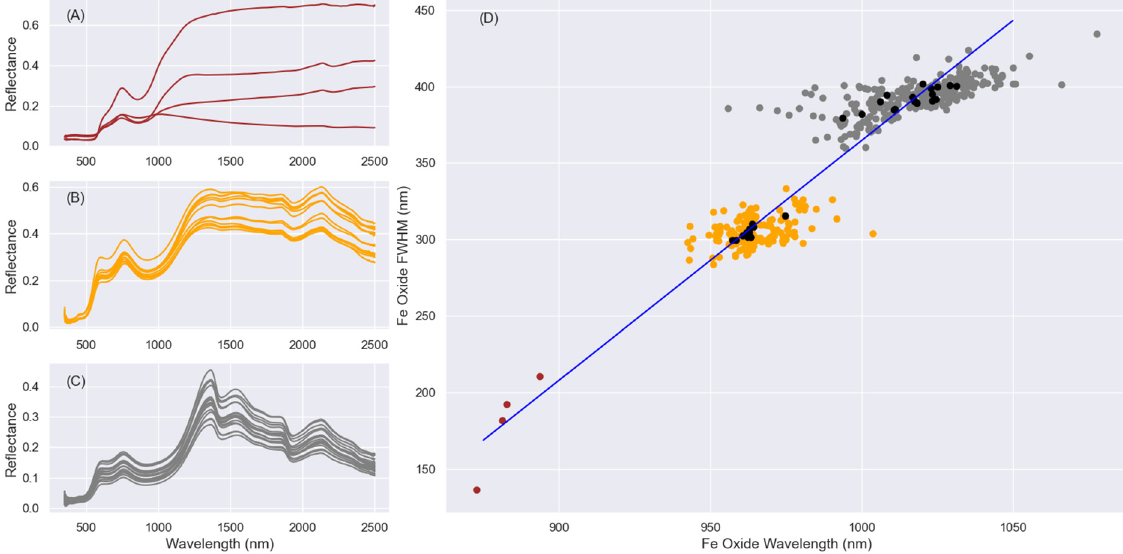
Figure 2. The spectral endmembers and their locations when plotted as continuum hull corrected Fe Oxide Wavelength versus FWHM. ( A – C ) show the resulting spectral averages of the available endmembers across the 6 differing particle sizes (not highlighted). ( A ) 3 hematite endmembers and 1 magnetite+hematite endmember, ( B ) 12 average ochreous goethite endmembers, ( C ) 18 average vitreous goethite endmembers. ( D ) The continuum hull corrected Fe Oxide Wavelength and Fe Oxide FWHM values of the spectral endmembers prior to any averaging are shown and coloured as per ( A – C ) for type identification. The samples shown as black points are the ochreous and vitreous spectral average iron boomerang values, while the line is to simply highlight that the boomerang values of the endmembers are approximately linear.